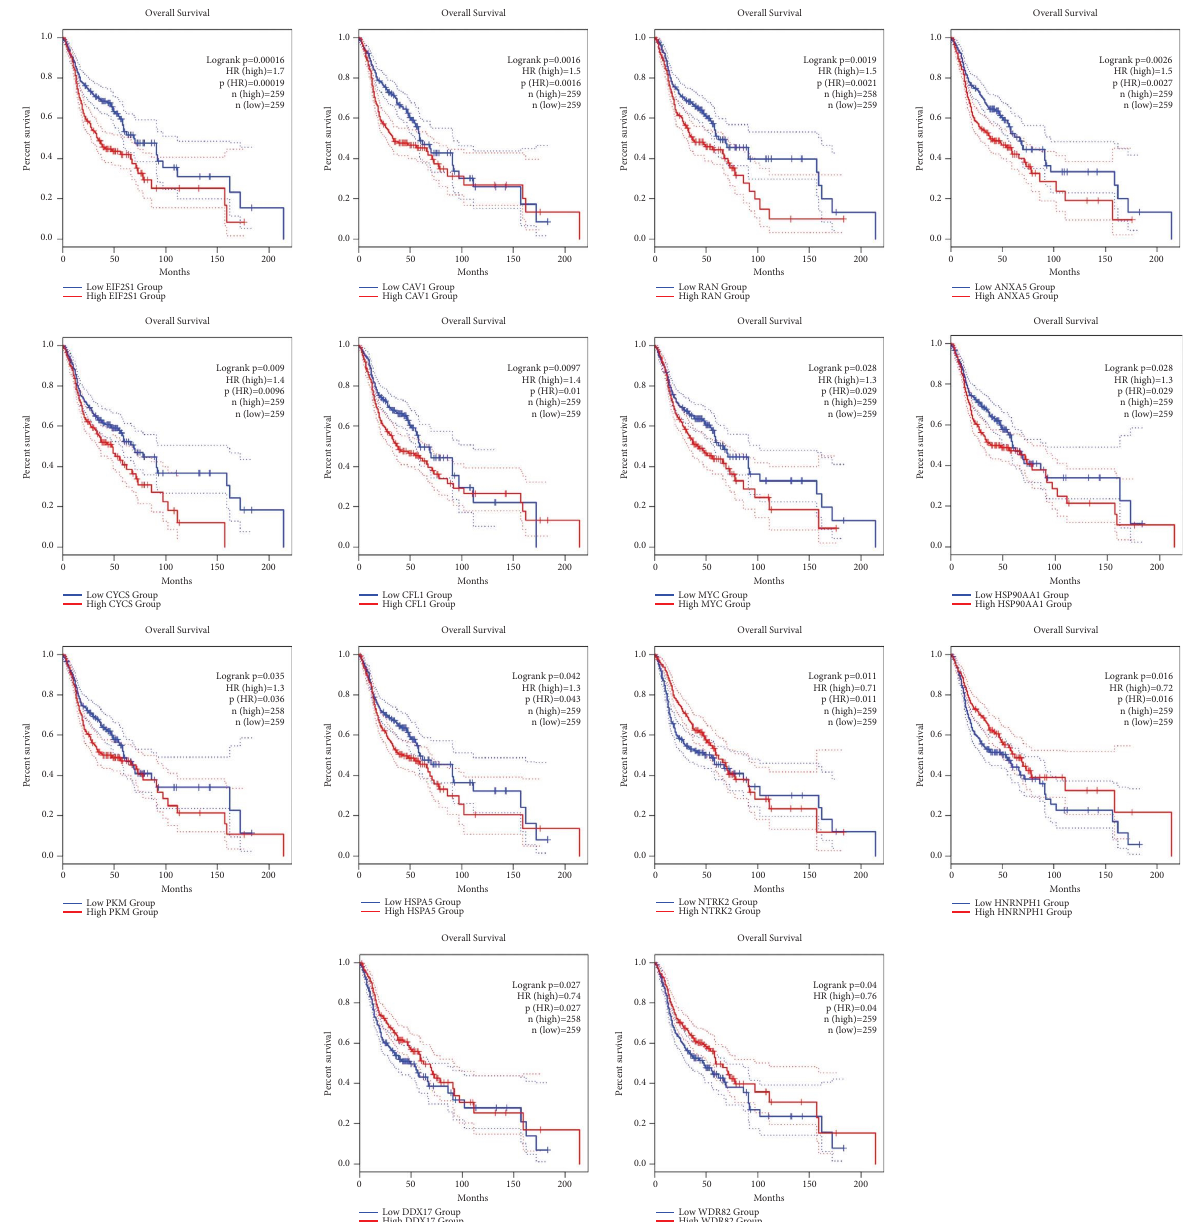
Figure 4: Survival analysis of EIF2S1, CAV1, RAN, ANXA5, CYCS, CFL1, MYC, HSP90AA1, PKM, HSPA5, NTRK2, HNRNPH1, DDX17, and WDR82 in patients with HNSCC. Blue and red lines show under- and overexpressed markers, respectively. Te y -axis and x -axis demonstrate the probability of survival and survival months of patients with HNSCC, respectively. Te dotted lines show a 95% confdence interval. HNSCC, head and neck squamous cell